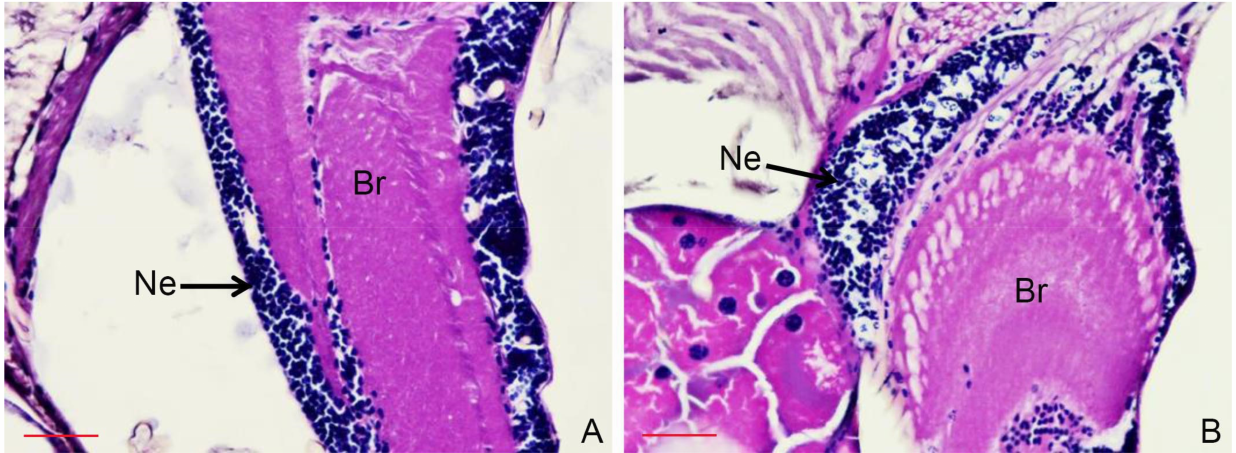
Figure 2. Histopathological changes in the brain of Stomoxys calcitrans : control ( A ) and at 24 h after treatment with Plectranthus amboinicus essential oil (12.05 µ g/fly) showing neuronal degeneration ( B ). Light microscope image of a paraffin section stained with hematoxylin and eosin. ( A , B ) Bar, 50 µ m. Br: brain; Ne: